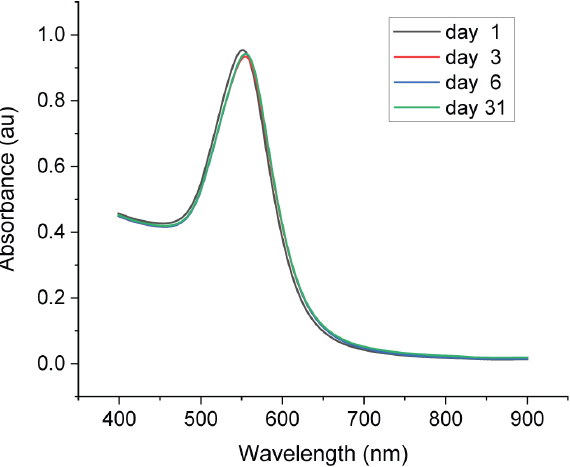
Figure 7. UV − Vis spectra of synthesized AuNPs recorded on day1, day 3, day 6 and day 31.